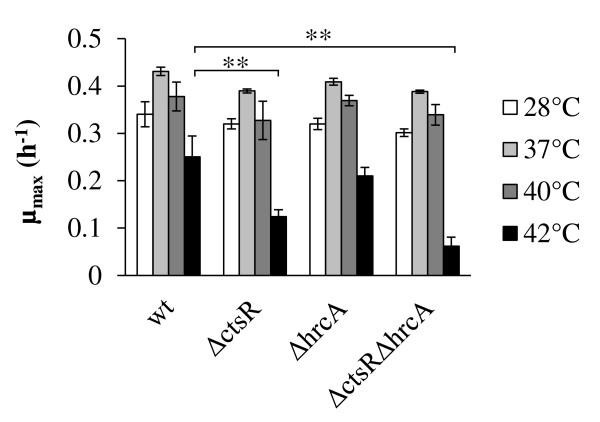
Maximum specific growth rates of L. plantarum WCFS1 (wt), NZ3410 (ΔctsR), NZ3425CM (ΔhrcA), and NZ3423CM (ΔctsRΔhrcA). Specific growth rates are shown for reference (28°C) and elevated (37°C, 40°C, and 42°C) temperatures as indicated in the figure legend. Asterisks indicate p-value < 0.001. Data shown are mean ± standard deviation of 3 independent experiments.